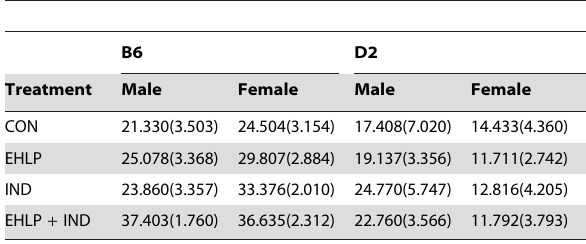
Table 3. Means and standard errors for percentage of time spent in open